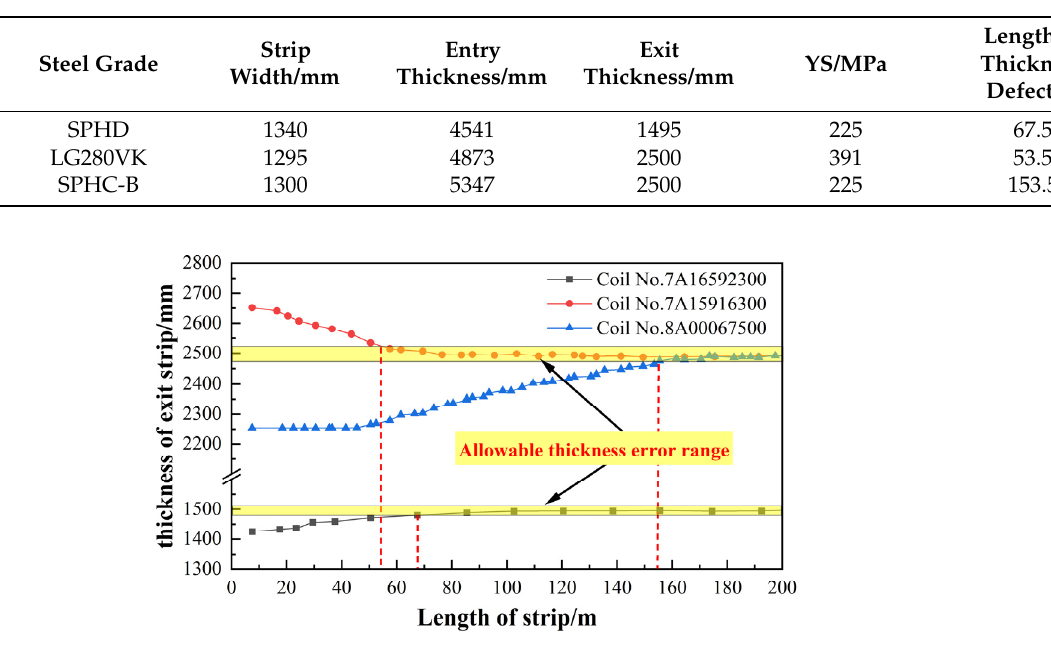
Table 4. The FGC strip before optimization.